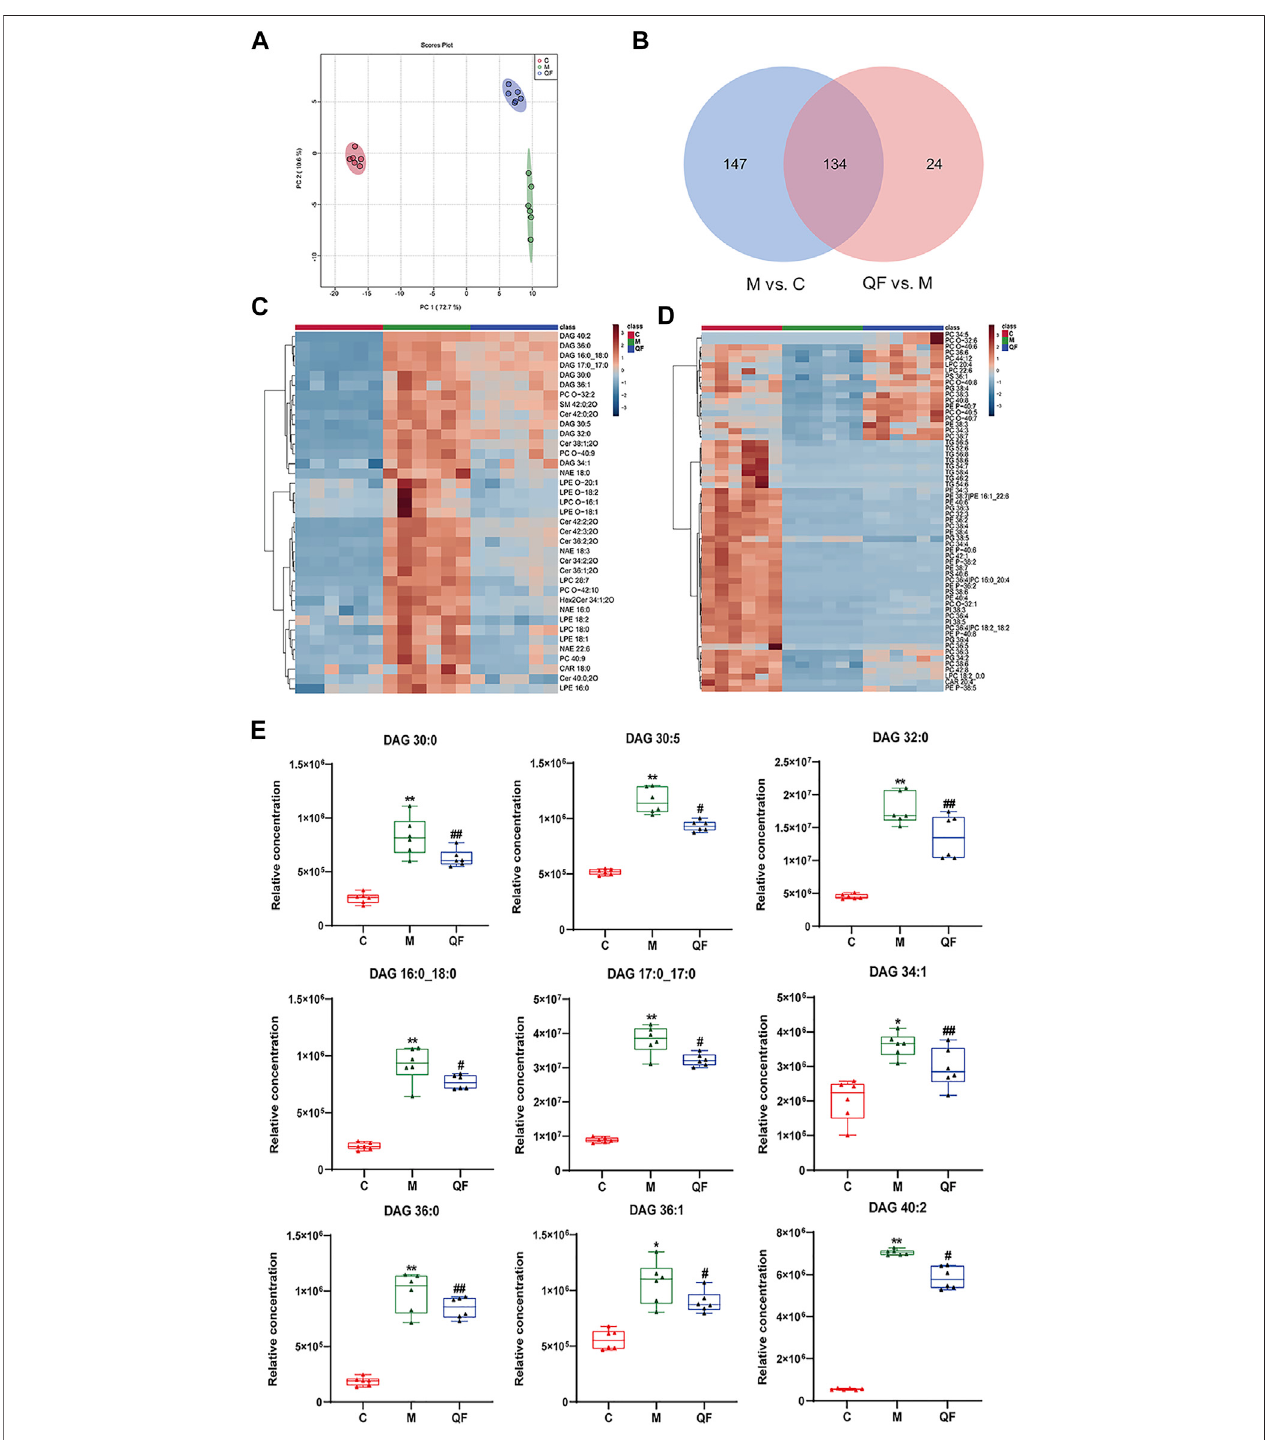
FIGURE 5 | Effect of QF on lipid metabolism in lung tissues of mice with RSV-induced lung in fl ammation. (A) PCA score plot based on lipid pro fi les among control (C), model (M), and therapy (QF) groups. (B) Venn diagram of differential metabolites identi fi ed in M vs. C and QF vs. M comparisons. (C) Heatmaps of differential lipid metabolitesup-regulatedinMvs.Cgroupsanddown-regulatedinQFvs.Mgroups. (D) Heatmapsofdifferentiallipidmetabolitesdown-regulatedinMvs.Cgroupsand up-regulated in QF vs. M group. (E) Boxplot of the relative concentrations of diglycerides (DAGs) in control (C), model (M), and therapy (QF) groups. * Compared with control group, # compared with model group, * p < 0.05, ** p < 0.01, # p < 0.05, ## p < 0.01). Abbreviations: QF, Qingfei oral liquid; RSV, respiratory syncytial virus; DAG diacylglycerol.